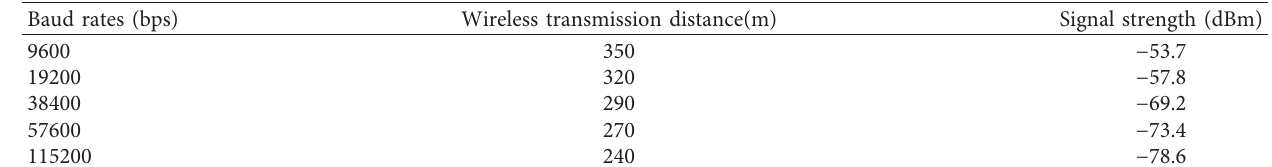
Table 4: Test result of wireless transmission performance test.